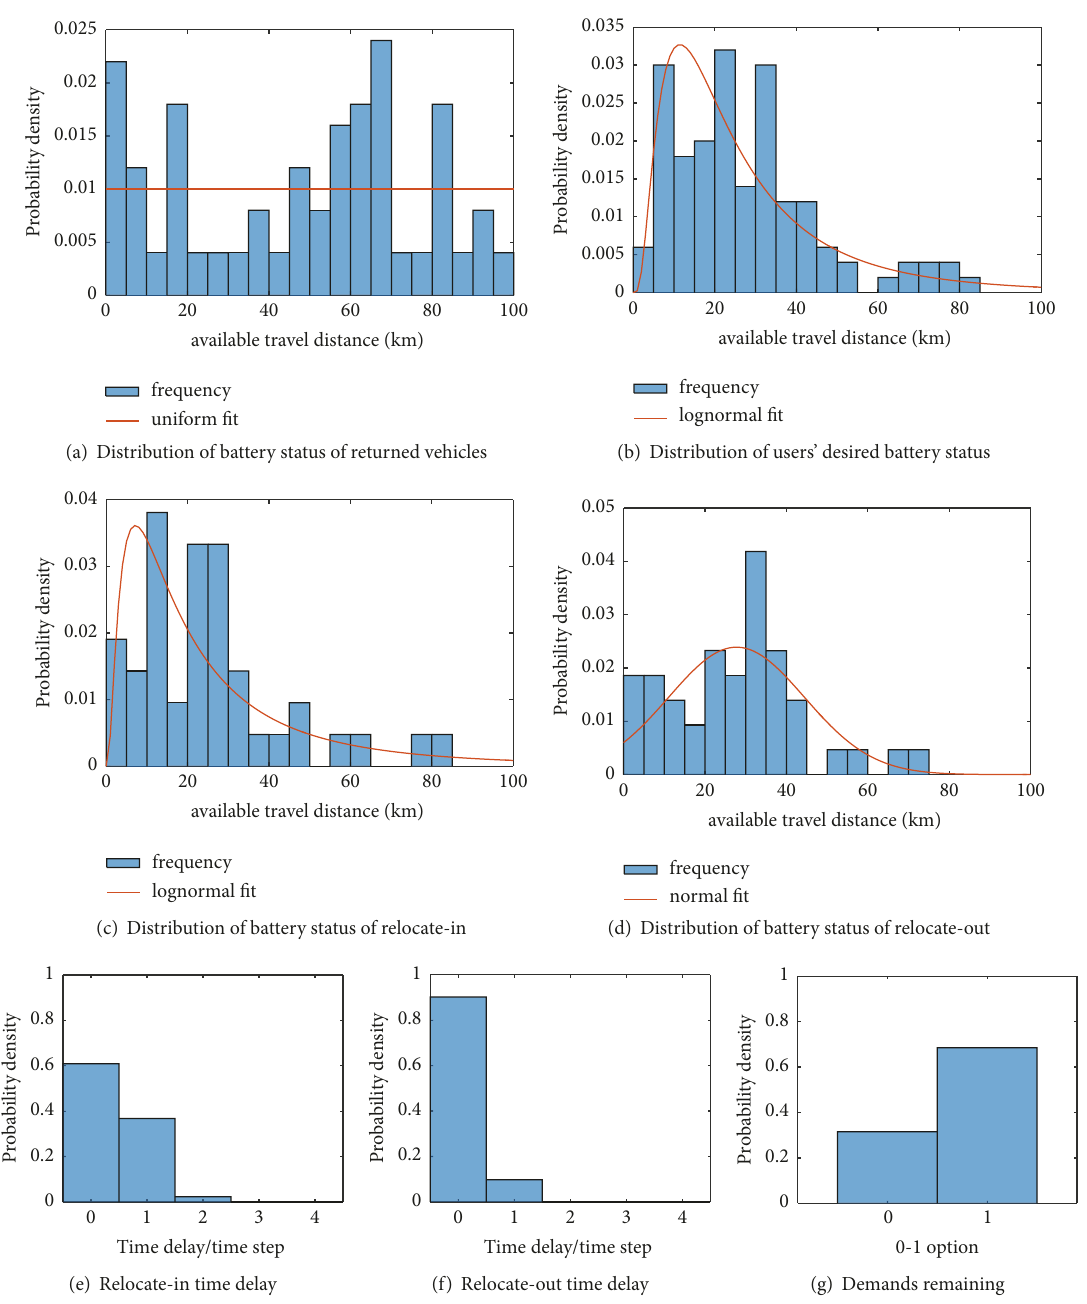
Figure 3: Distribution of discretized variables.